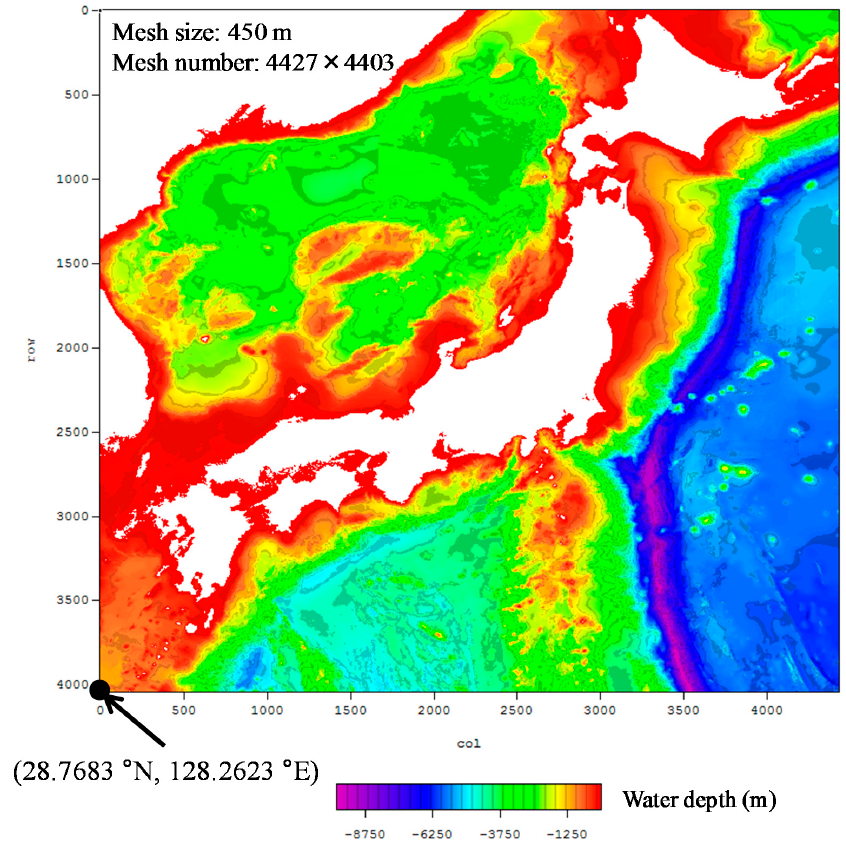
Figure 7. Calculation area for the tsunami numerical simulation (450 m mesh).